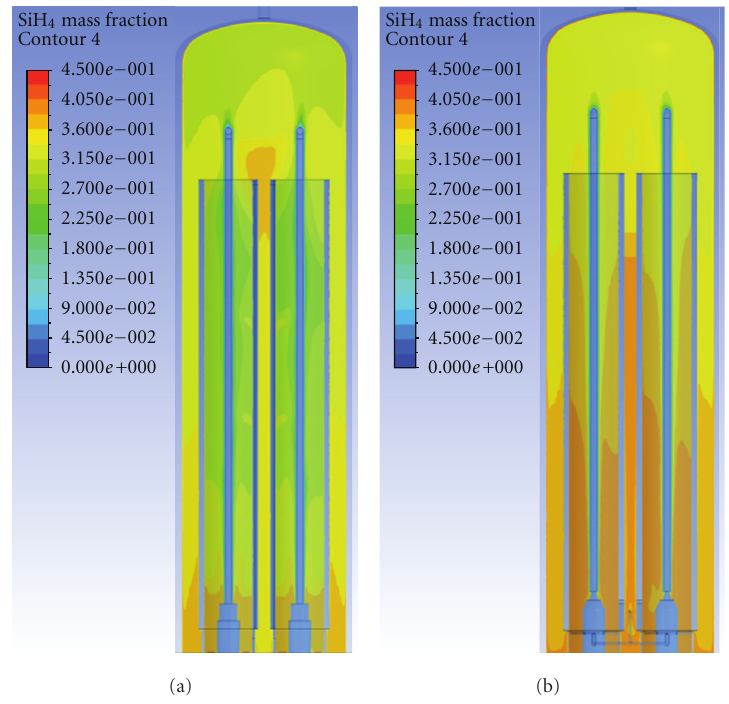
Figure 4: Simulation analysis of SiH 4 mass fraction between nozzle (a) type A and (b)